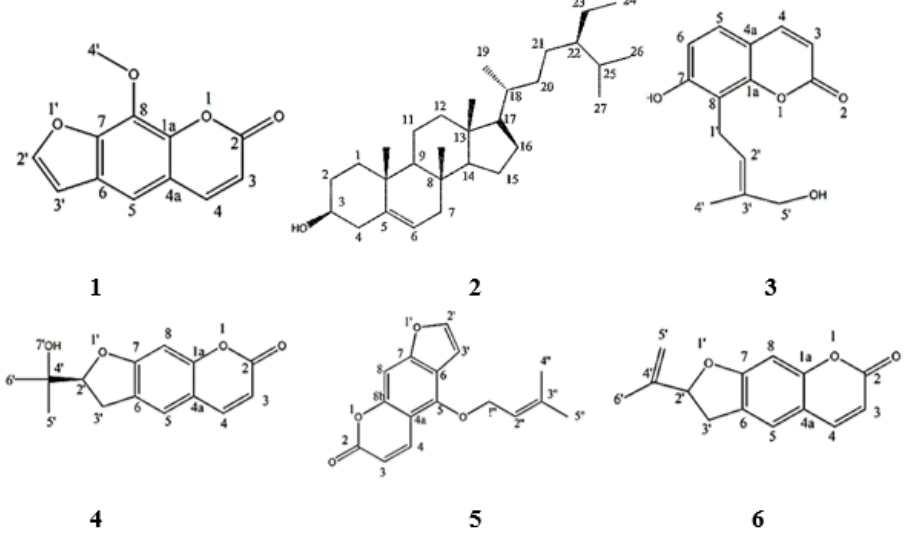
Figure 2. Compounds isolated from the CH 2 Cl 2 fraction of AME. Xanthotoxin ( 1 ), β -sitosterol ( 2 ), Isoarnottinin ( 3 ), Marmesin ( 4 ), Imperatorin ( 5 ), Ammirin ( 6 ).